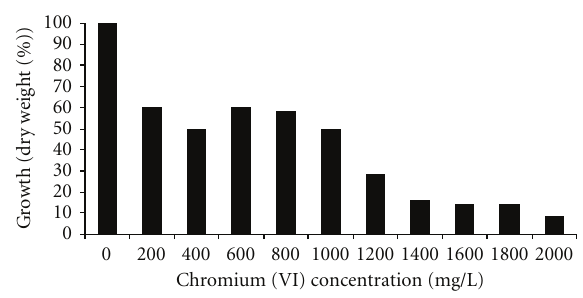
Figure 1: Growth in dry weight of Paecilomyces sp. with di ff erent concentrations of Cr(VI). 1 × 10 5 spores/mL, 28 ◦ C, 7 days of incubation, 100rpm.